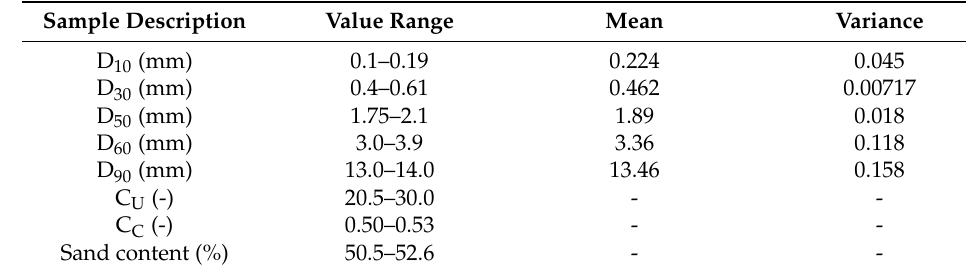
Table 1. Soil Gradation Curve Properties.